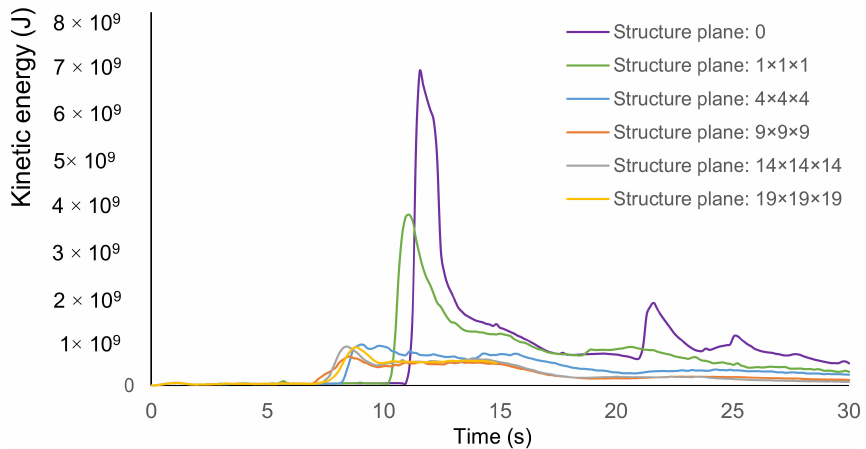
Figure 14. Kinetic energy of river water over time.